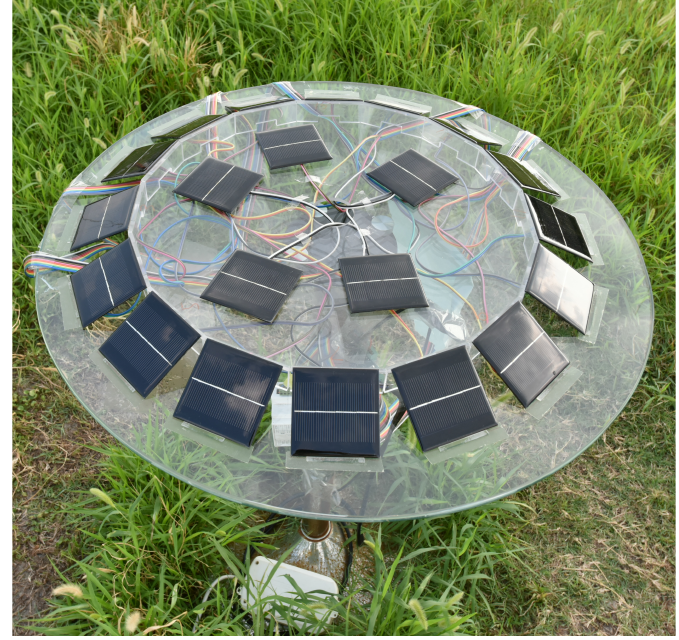
Figure 6. The sensor array for determining the solar